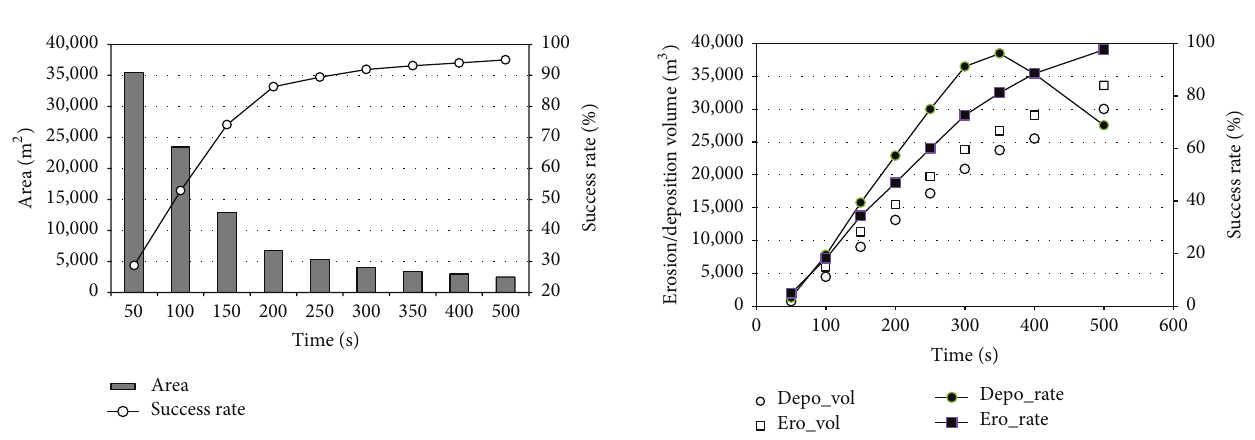
Figure 10: Variation of discordance area and the success rate.